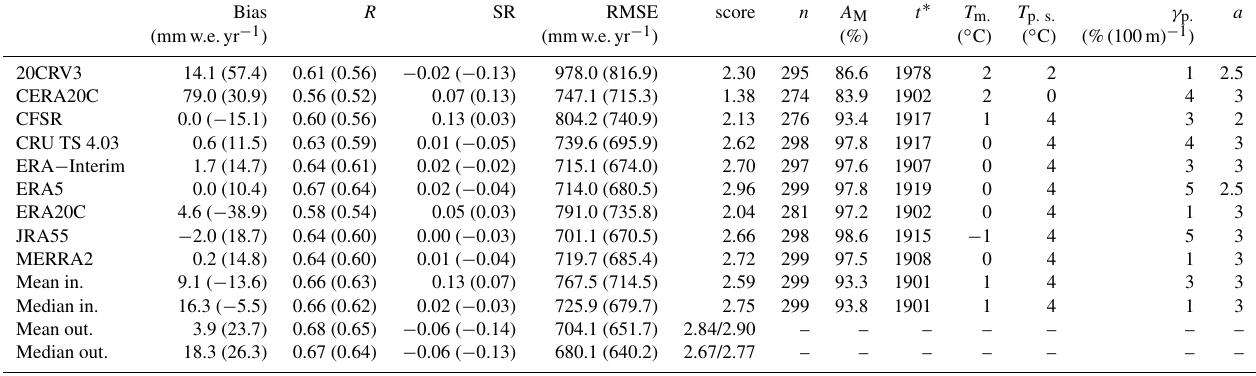
Table 2. Values of the performance measures for each tested data set, applying the best-scored parameter set. Values behind coefficients in brackets display non-weighted averages (see text). For the mean and median model output, the score with/without CERA20C is displayed. The total number of cross-validated glaciers used for the respective data set is n . A M is the percentage of glacier area (as recorded in the RGI) covered by the glaciers the model was able to initialize. The last five columns contain the selected global parameters (see Eqs. 1–5). Bias R SR RMSE score n A M t ∗ T m . T p . s .